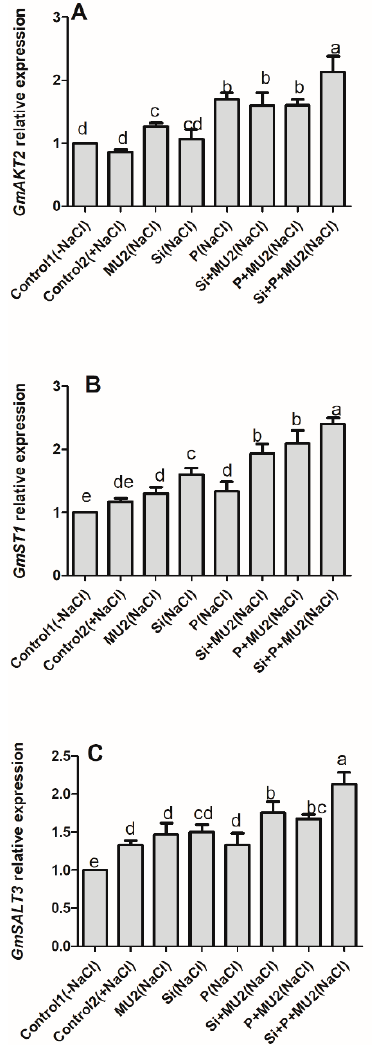
Figure 4. P. koreensis MU2 activates the transcription factor to help soybean plants tolerate salt stress. Relative expression of different genes: ( A ) K + ion regulating gene GmAKT2 salt resistant gene; ( B ) GmST1 ; ( C ) GmSALT3 . Error bars represent standard deviations. Each data point represents the mean of at least three replications. Bars with different letters are significantly different from each other at p ≤ 0.05.